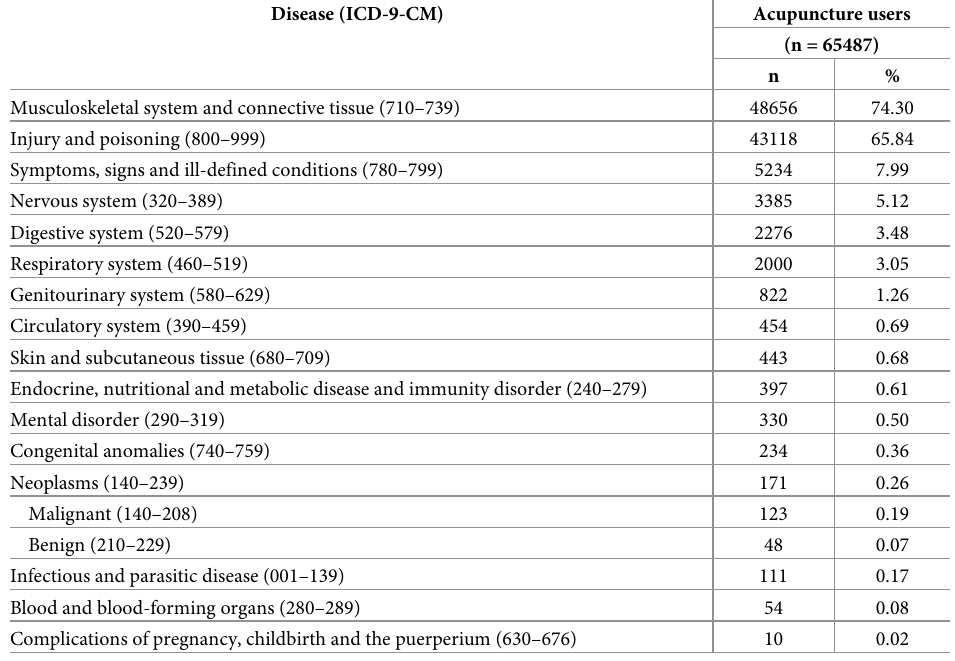
Table 4. The distribution of acupuncture cohort by disease categories/diagnosis in patients with fibromyalgia. Disease